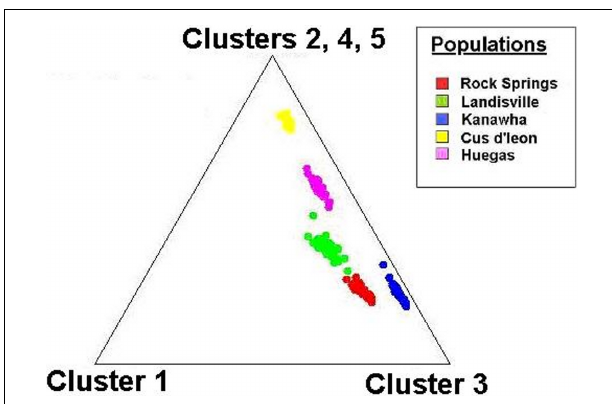
FIGURE 4 | Cluster analysis of the ancestry coefficient ( Q ) among individual SNP genotypes collected at O. nubilalis sample sites. The individual ancestry vectors on the triangle plot are representative of North American and European samples, and are derived from K = 5 components (assumed number of independent populations during analyses). Each components are displayed as the distance to the corresponding corner of the triangle, where individual genotypes at the points of the triangle are completely assigned to a single population of